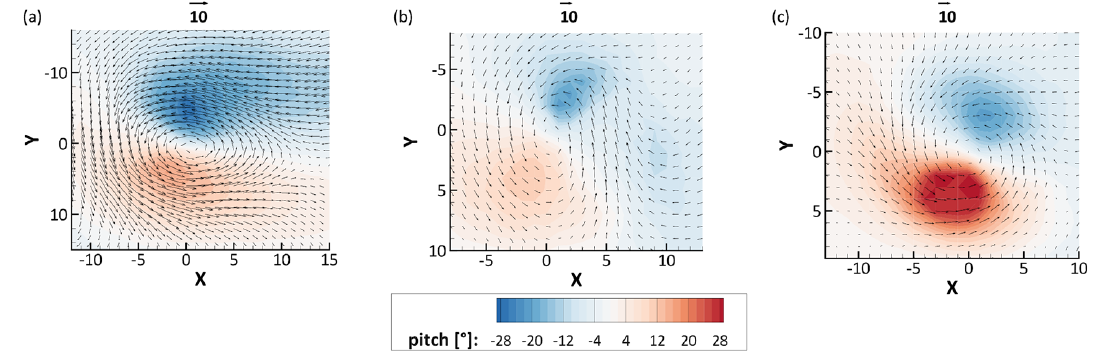
Int. J. Turbomach. Propuls. Power 2020 , 5 , x FOR PEER REVIEW Figure 7. 5-hole probe pitch angle results for: ( a ) type A, ( b ) type B and ( c ) type C swirlers.